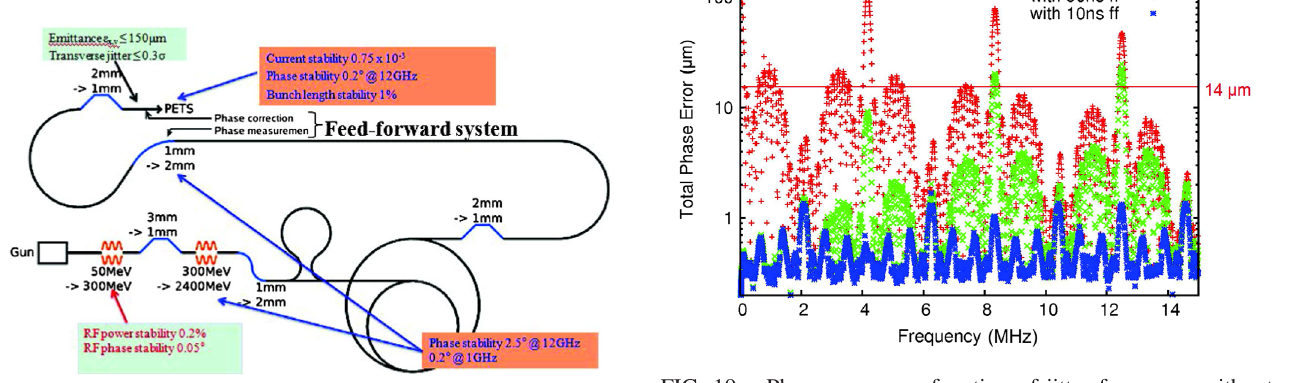
FIG. 18. Drive beam layout with indicated position of the feed- forward system and the tolerances for various drive beam parameters along the beam.